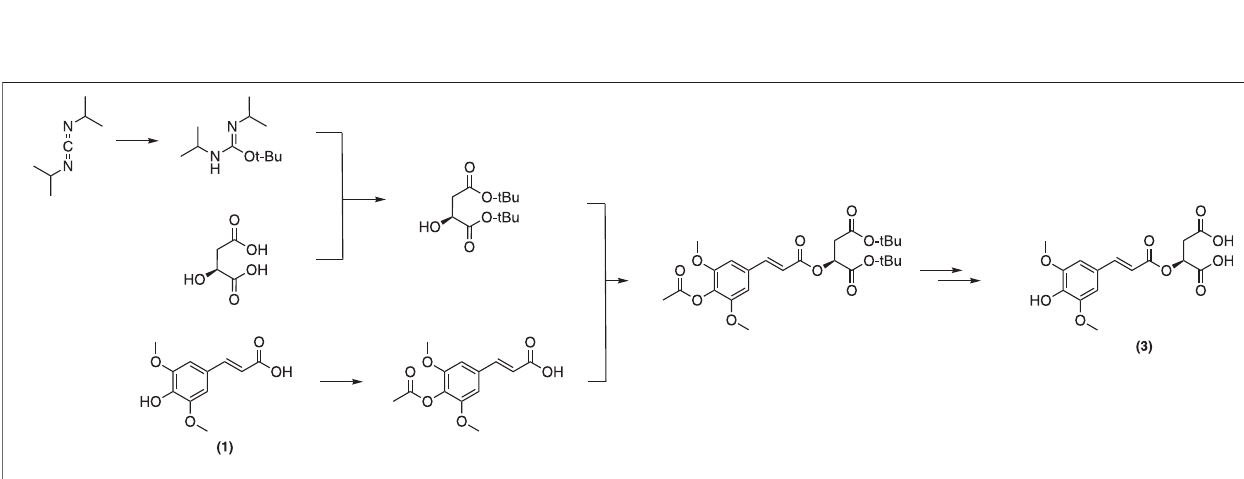
FIGURE 13 | Synthesis of sinapoyl glucose described by Zhu et al.